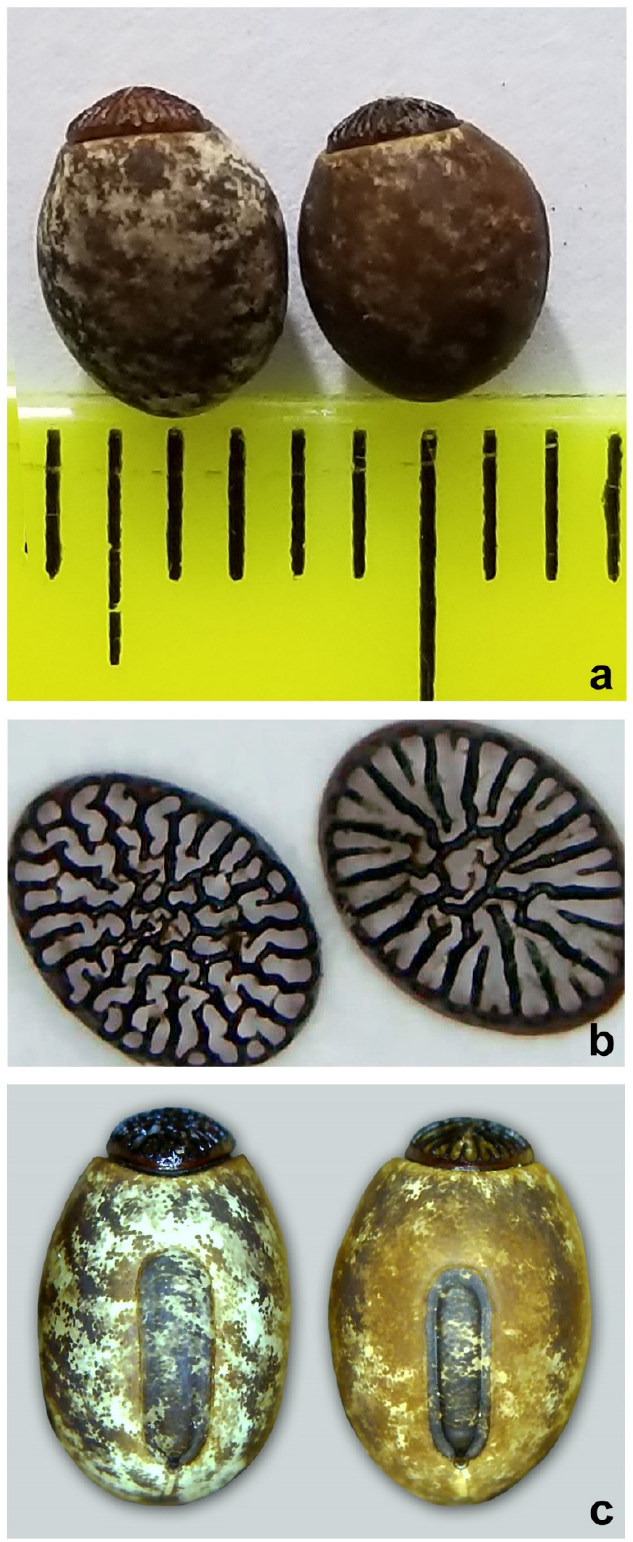
Figure 7. General aspect of the eggs under stereo microscopy. ( a ) Cladomorphus petropolisensis and C. phyllinus , respectively; ( b ) detail of the operculum for the mentioned species; ( c ) detail of the micropylar plate for the mentioned species.